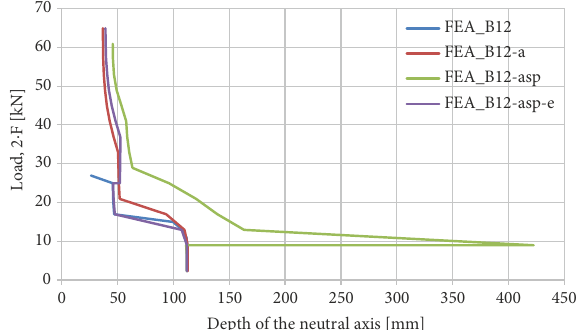
Fig. 4. Depth of the neutral axis predicted numerically.